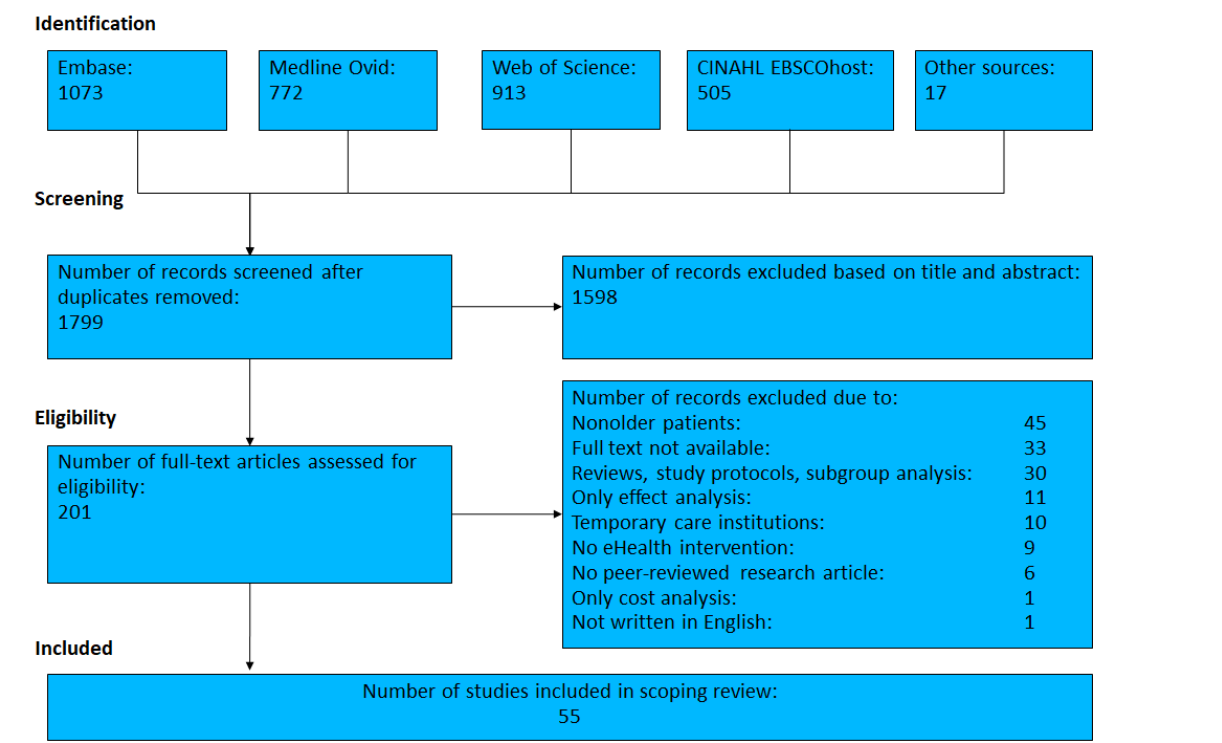
Figure 1. Flowchart of paper